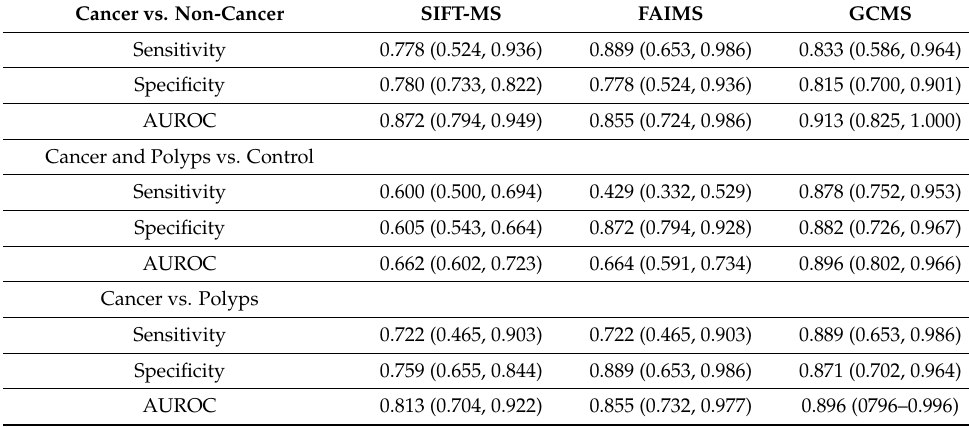
Table 3. Diagnostic accuracy data with 95% confidence intervals for each patient group and volatile organic compound method. AUROC—area under the receiver operator curve. Cancer vs.